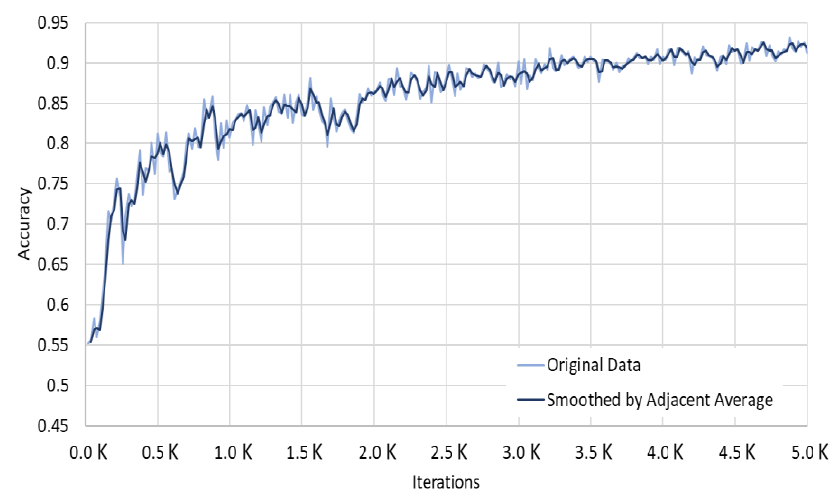
Figure 10. MASK R-CNN Segmentation Accuracy Curve (source: TensorBoard Image).